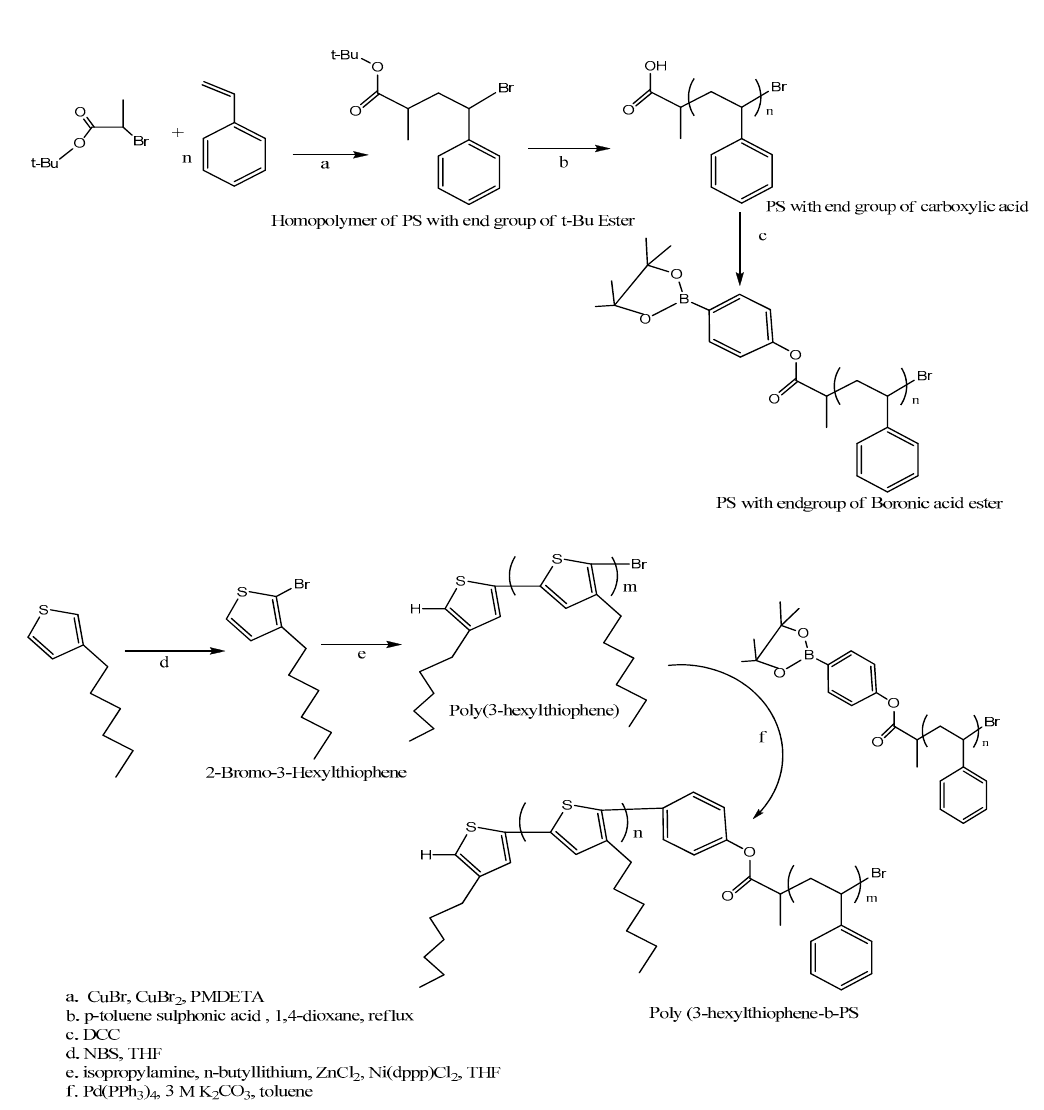
Figure 7. Synthesis route of diblock copolymer P3HT- b -PS.